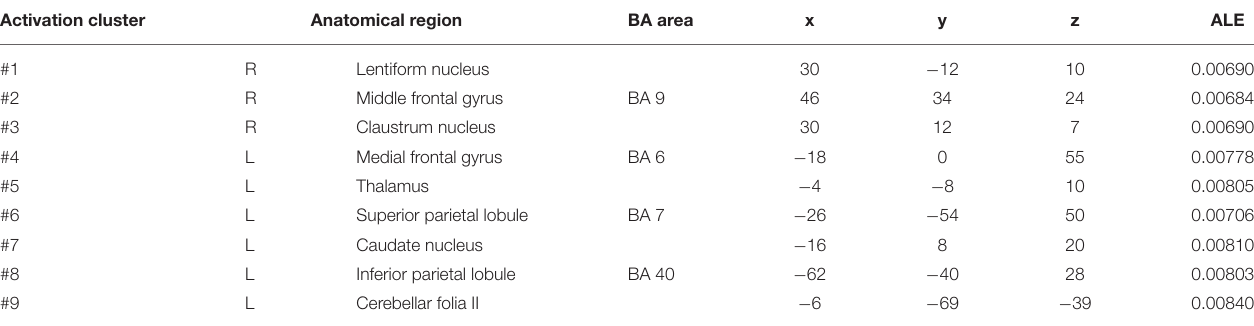
TABLE 7 | Clusters with HC > PD activation in cue-priming conditions. Activation